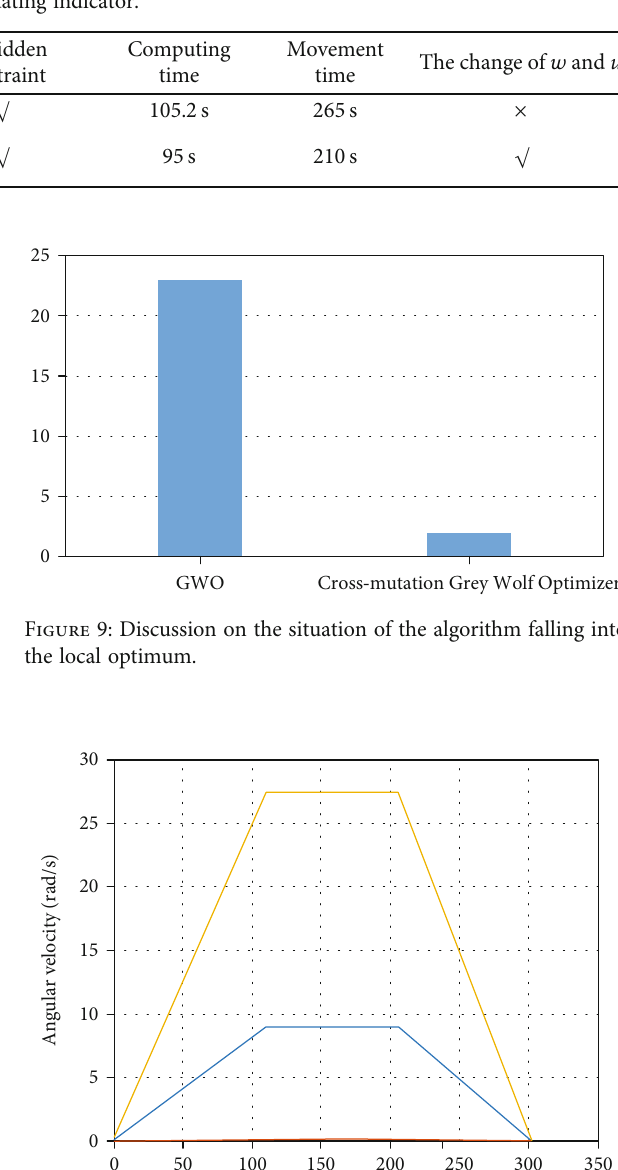
Table 4: Evaluating indicator.